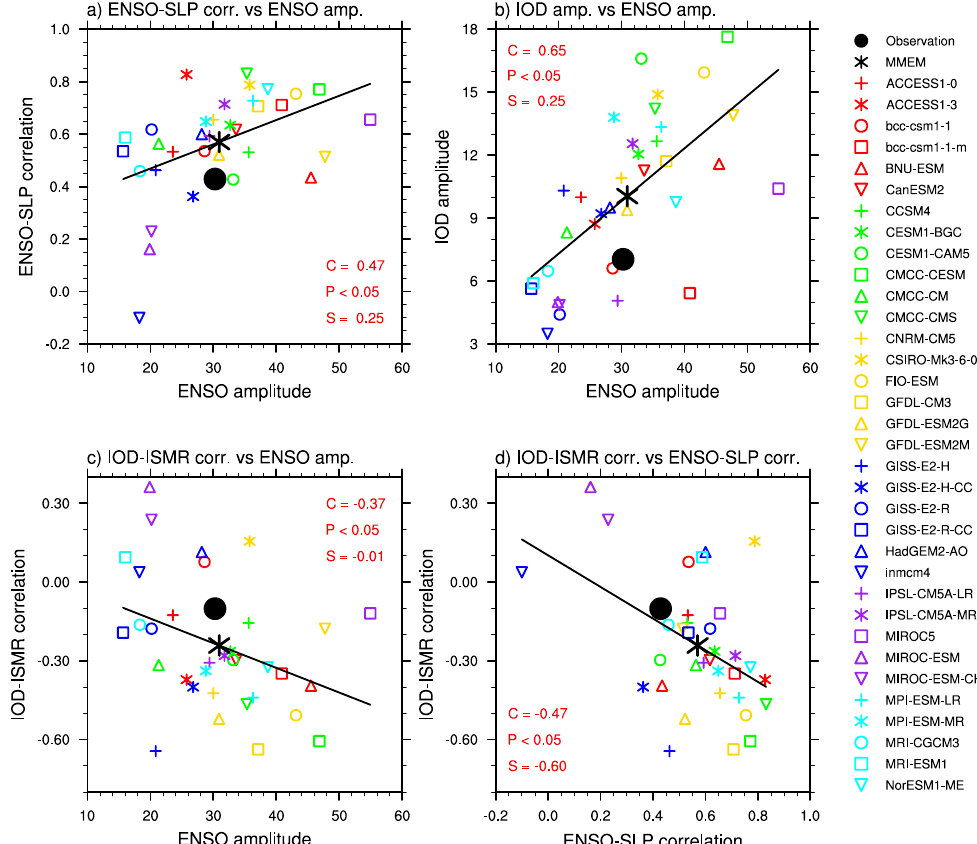
Figure 3. Inter-model relationships among ENSO, IOD and its atmospheric correlations. Inter-model relationship in present-day climate between ( a ) ENSO-SLP correlation and ENSO amplitude, ( b ) IOD amplitude and ENSO amplitude, ( c ) IOD-ISMR correlation and ENSO amplitude, and ( d ) IOD-ISMR correlation and ENSO-SLP correlation. The observations and MMEM are shown as the black circle and black asterisk, respectively. Each colored symbol represents a CMIP5 model. Solid line in each plot denotes the linear regression line with correlation coefficient (C), p-value (P) and regression coefficient (S) provided. A p-value smaller than 0.05 means statistical significance above the 95% confidence level. All plots were generated by NCL version 6.3.0